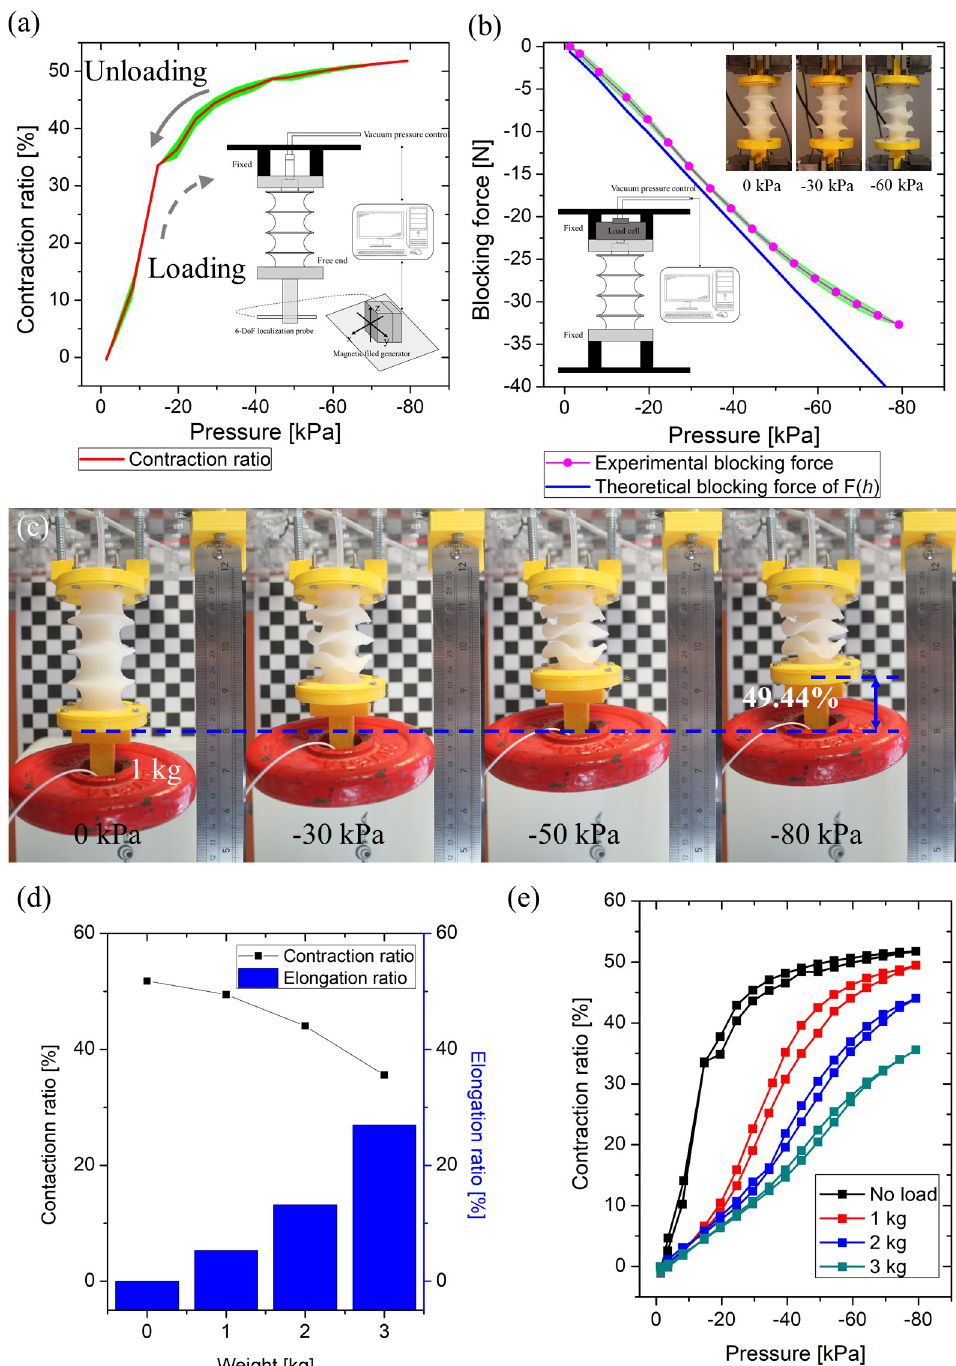
Fig 6. Experimental results of static and quasi-static characteristics of the UH-PAM: (a) contraction ratio versus pressure characteristics; (b) comparison between the experimental (pink) and theoretical (blue) blocking force; (c) sequence of images showing lifting of 1kg lifting by negative pressure; (d) comparison of contraction and elongation ratio according to the attached weight from 1 to 3 kg; (e) contraction ratio versus pressure graph according to the attached weight from 1 to 3